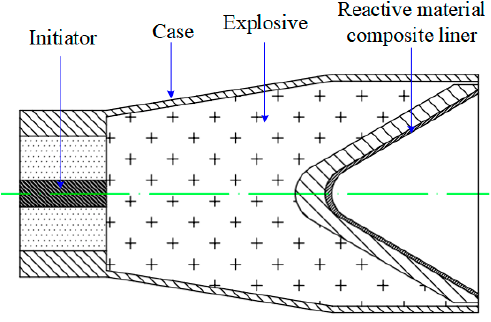
Figure 3. Schematic structure of the SC with the reactive material composite liner.